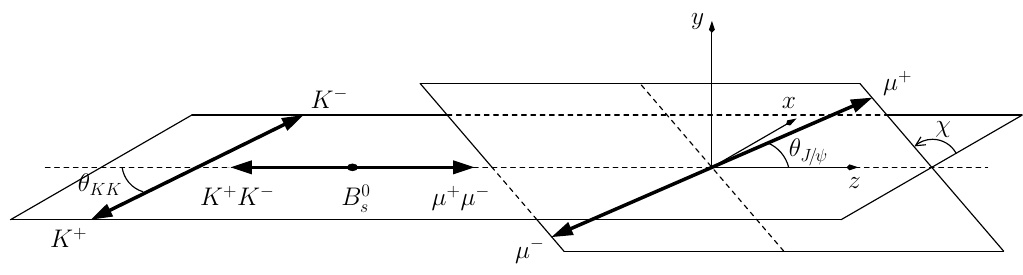
Figure 1 . De(cid:12)nition of the helicity